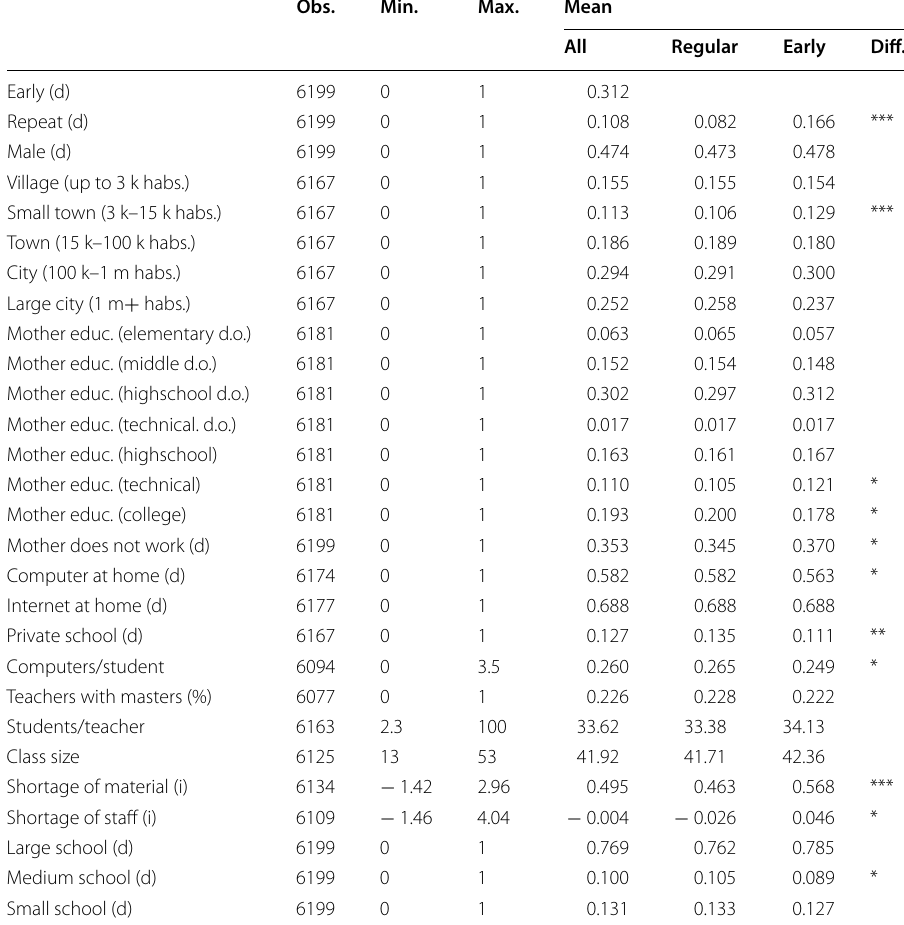
All and by regular and early